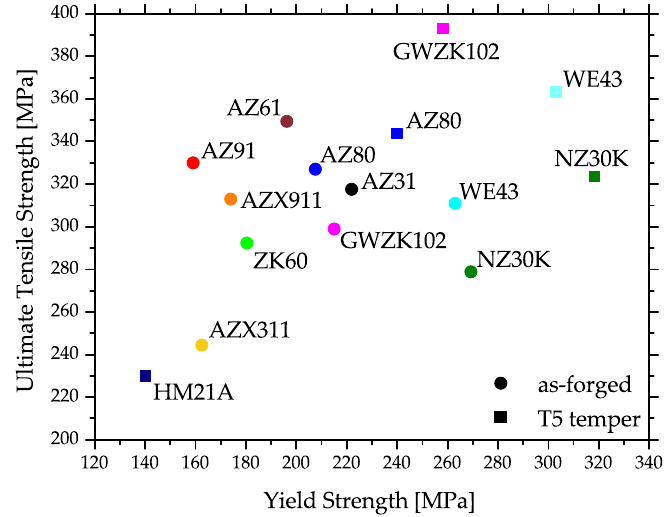
Figure 5. Tensile properties of various Mg alloys, showing as-forged and artificially aged (T5) values at room temperature (RT). The graphic shows mean values calculated from various scientific sources. A more detailed overview is given in Appendix